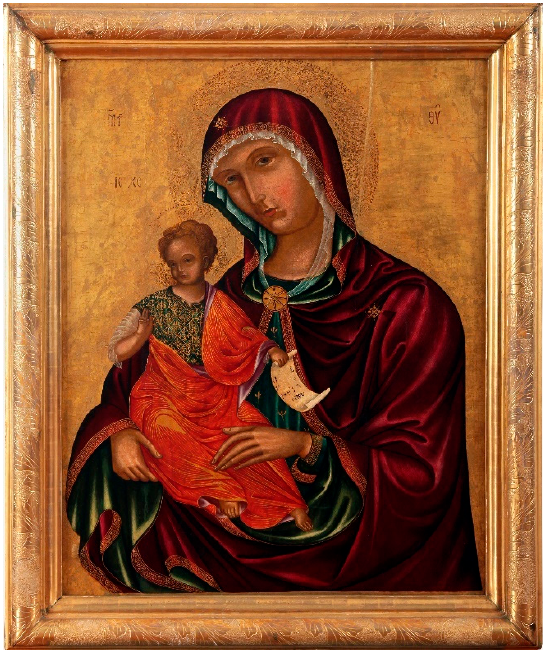
Figure 6. Circle of Nikolaos Tzafoures, Madre della Consolazione, Hvar, Biskupski Muzej (provenance: Church of the Annunciation of the Virgin) © Živko Ba č i ć .